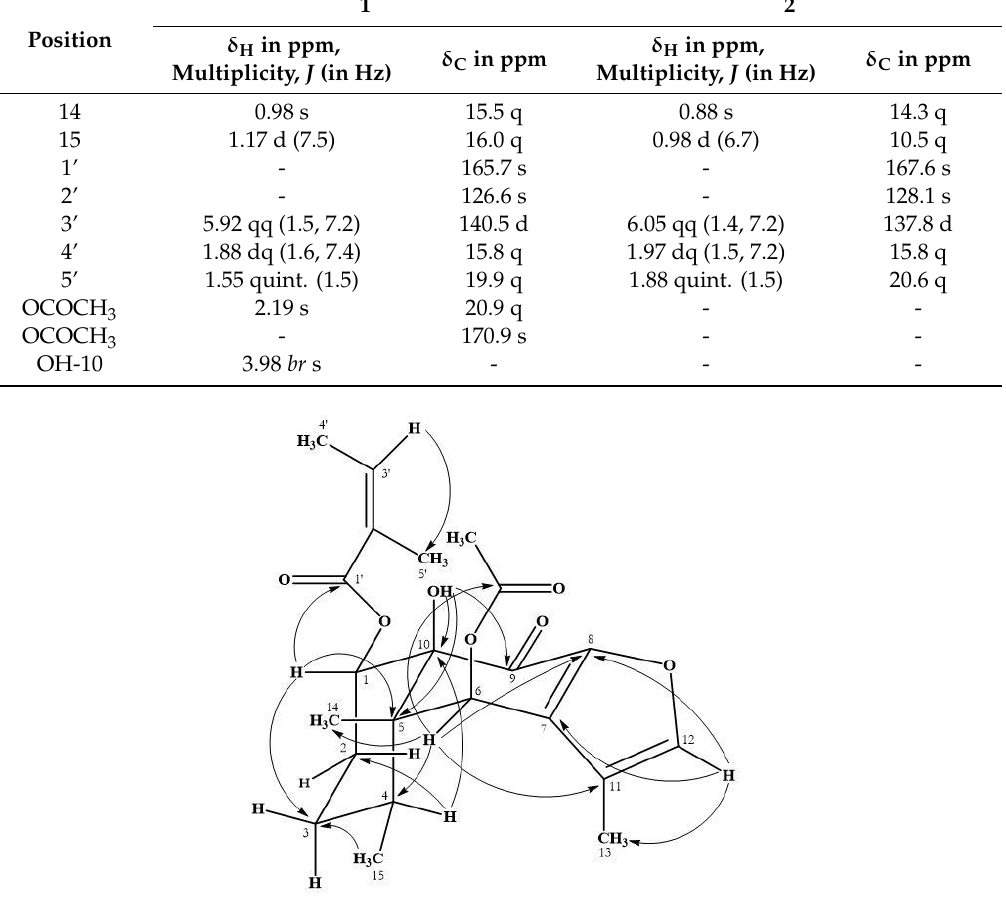
Figure 2. HMBC correlations observed for compound 1 .